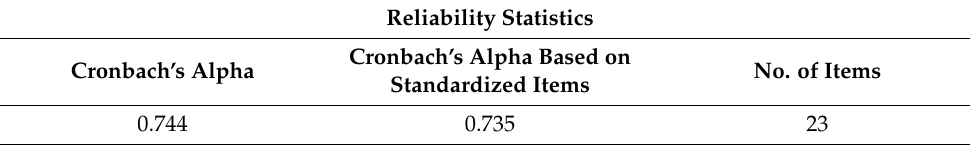
Table 2. Survey reliability measurement using Cronbach’s alpha